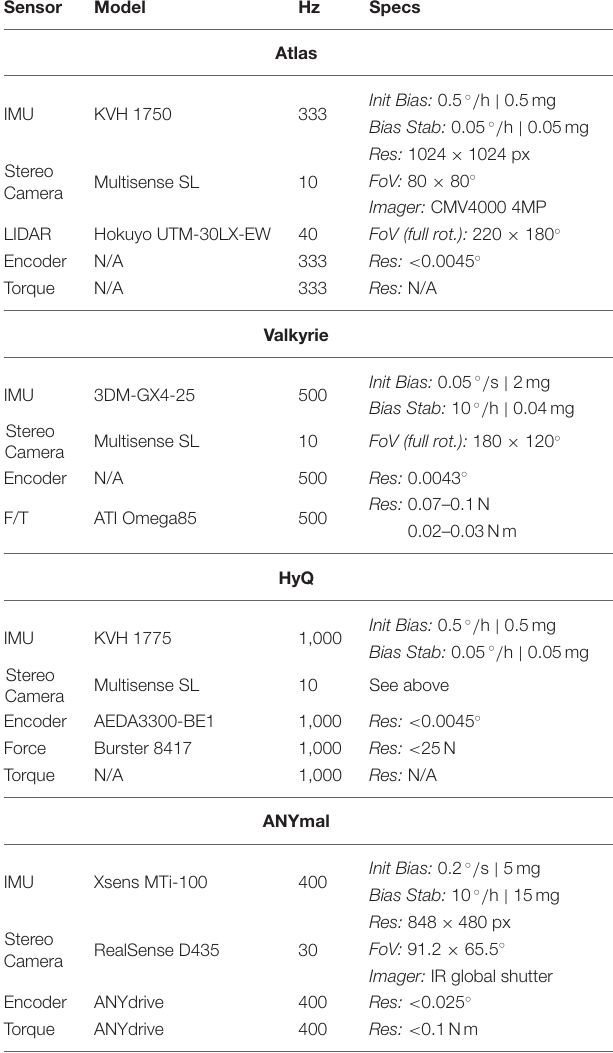
TABLE 1 | Sensor specifications divided by